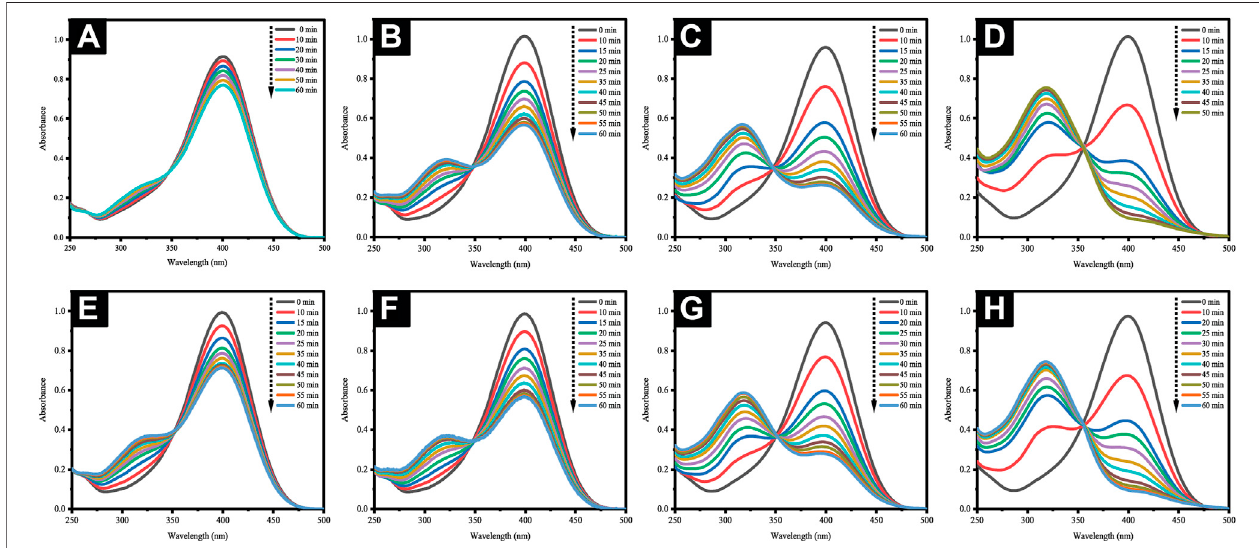
FIGURE 13 | (A) UV-Vis spectra of 4-nitrophenolate ions devoid of AuNPs. Time-dependent UV-Vis spectra for the reduction of 4-NP with AuNPs@pH10: (B) 1 mg, (C) 2 mg and (D) 3 mg; AuNPs@pH6: (E) 1 mg, (F) 2 mg, (G) 3 mg and (H) 4 mg.